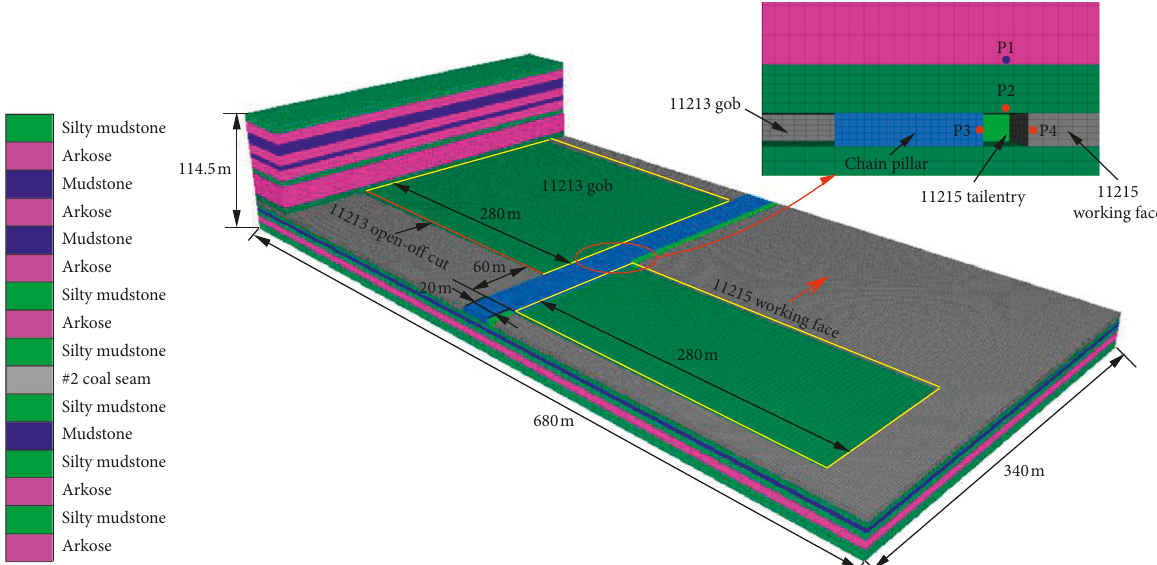
Figure 14: Model